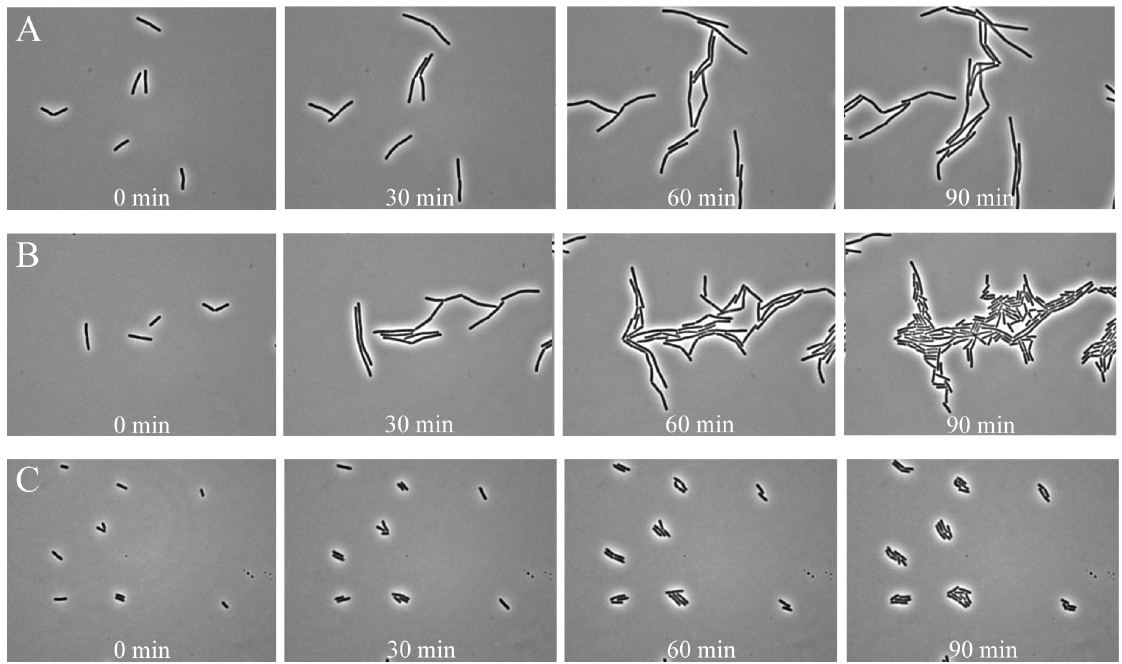
Figure 3. Time-resolved images showing growth and division of B.subtilis 1A700 vegetative cells using different media. Exponentially growing cells were spotted on 2.5% complex medium (TSB and LB shown in panel A and B , respectively) and 100% defined minimal (MOPS-buffered) medium ( C ), and followed in time using phase-contrast microscopy. doi:10.1371/journal.pone.0058972.g003 and Fig. 7C). No significant difference was found in the mean between control and heat-treated spores (Table 2, and Fig. 7D).